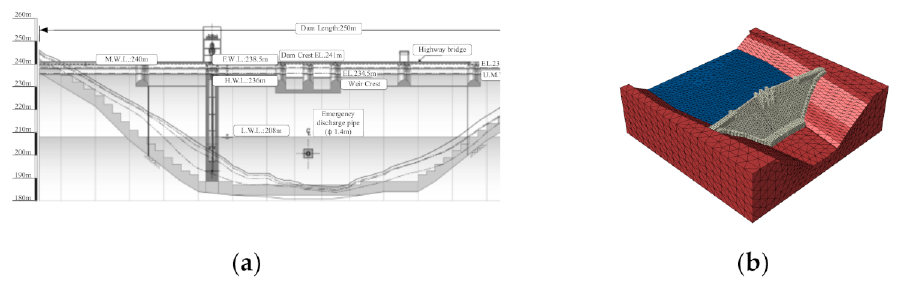
Figure 5. ( a ) The geometrical dimension of sectional view, ( b ) finite element model (FEM) 3D model with meshing.